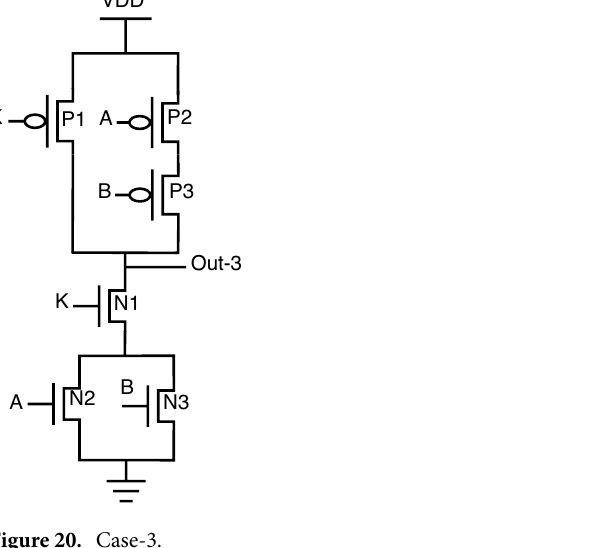
Figure 20. Case-3.